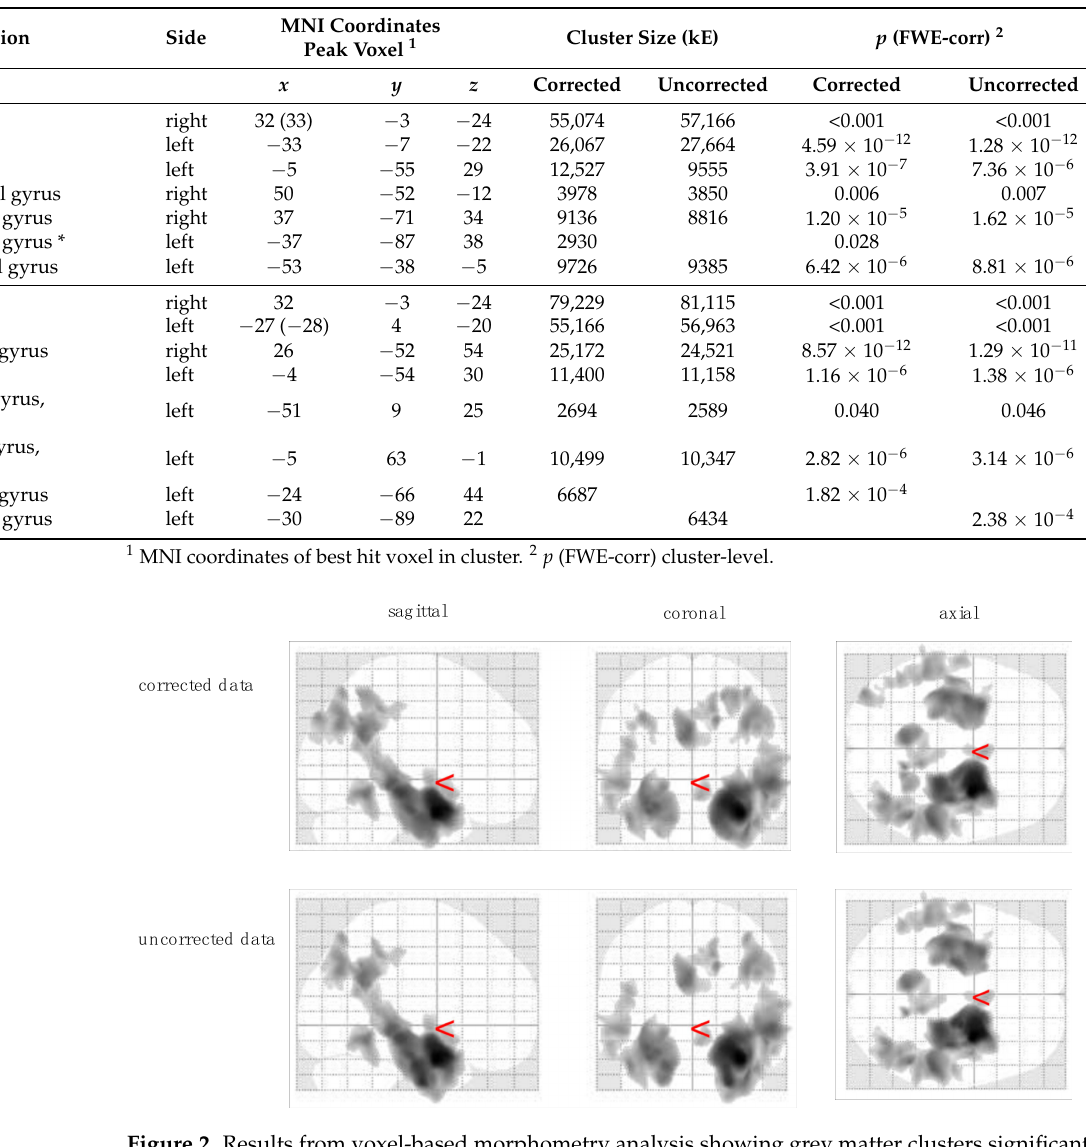
Figure 2. Results from voxel-based morphometry analysis showing grey matter clusters significantly correlating with CVLT immediate recall score (CVLT_1–5).